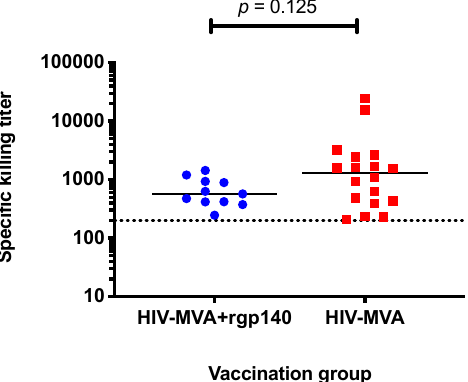
Figure 7. Magnitude of ADCC-mediating antibody responses in responding vaccinees. ADCC-mediating antibody responses to CM235 CRF01_AE infected cells were assessed using